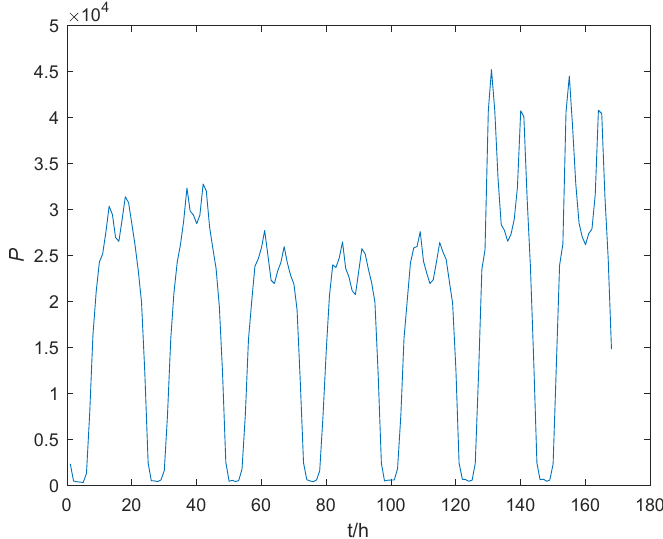
Figure 10. Multi-day load data of charging stations.